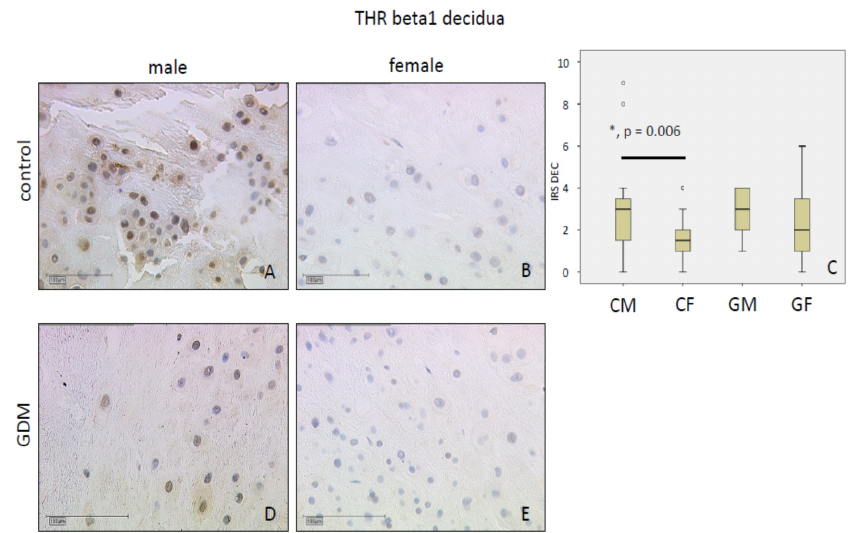
Figure 3. THR β 1 immunoreactivity is found with median intensity in SCT in controls ( A , B ) and in GDM ( D , E ). IRS for each group are shown as box plots for SCT (IRS SCT) ( C ). The boxes represent the range between the 25th and 75th percentiles with a horizontal line at the median. The circles indicate values more than one and a half box lengths, and the asterisk values more than three box lengths from the 75th percentile. Groups are labelled as follows: CM = control male; CF = control female; GM = GDM male; GF = GDM female. Scale bar = 100 µm.